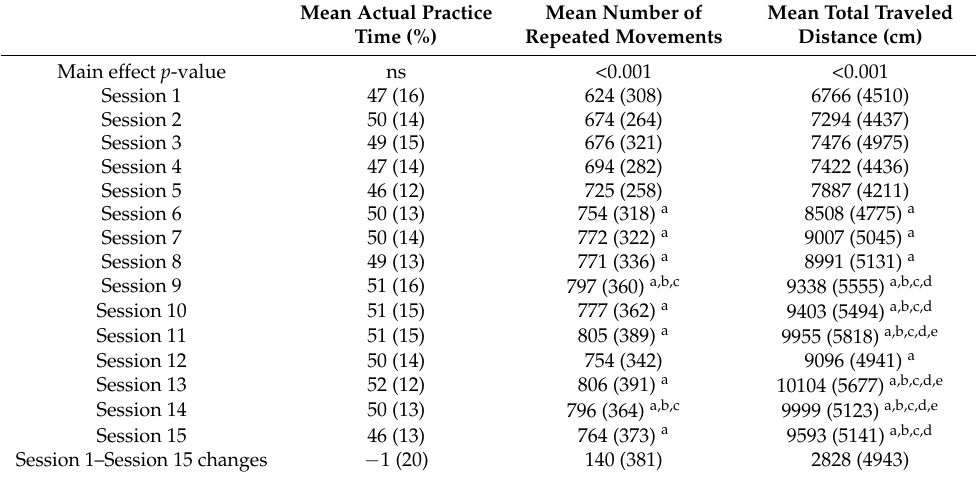
Table 3. Robot-based variables (all training modalities pooled) over 15 sessions of RT.